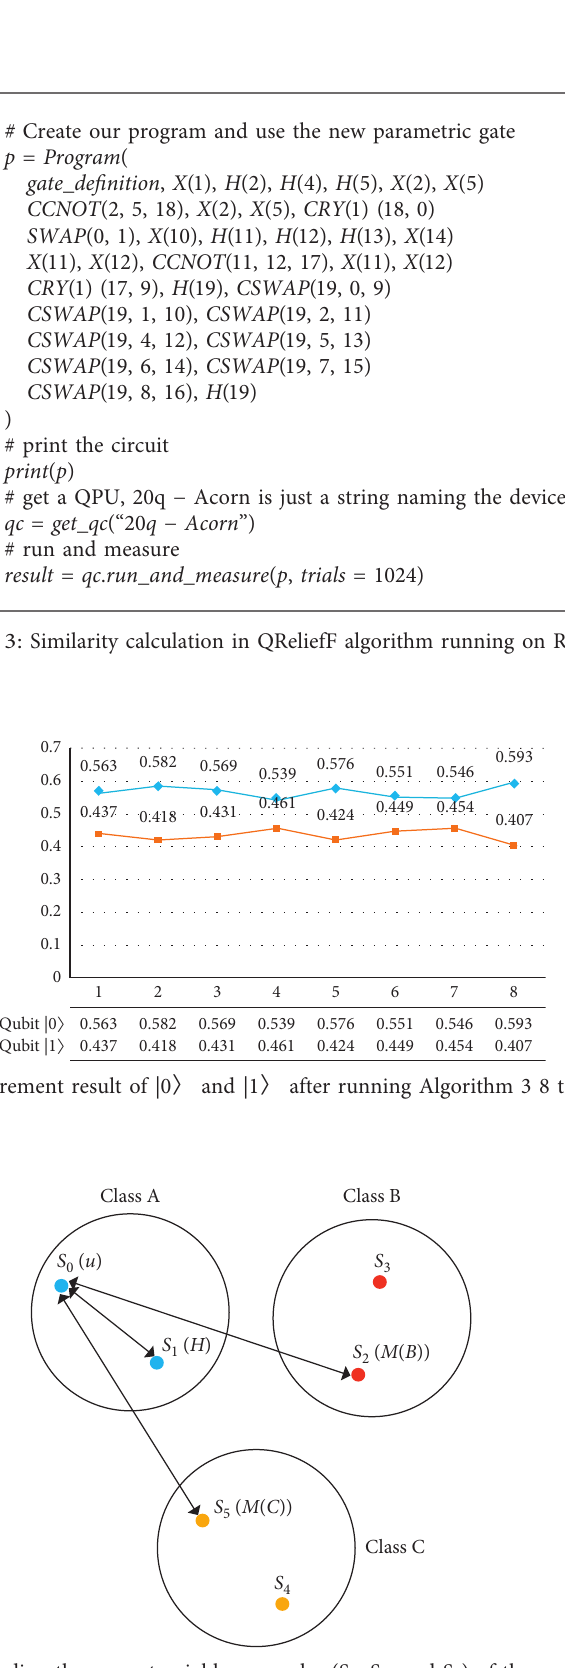
1 , S 2 , and S 5 ) of the sample S 0